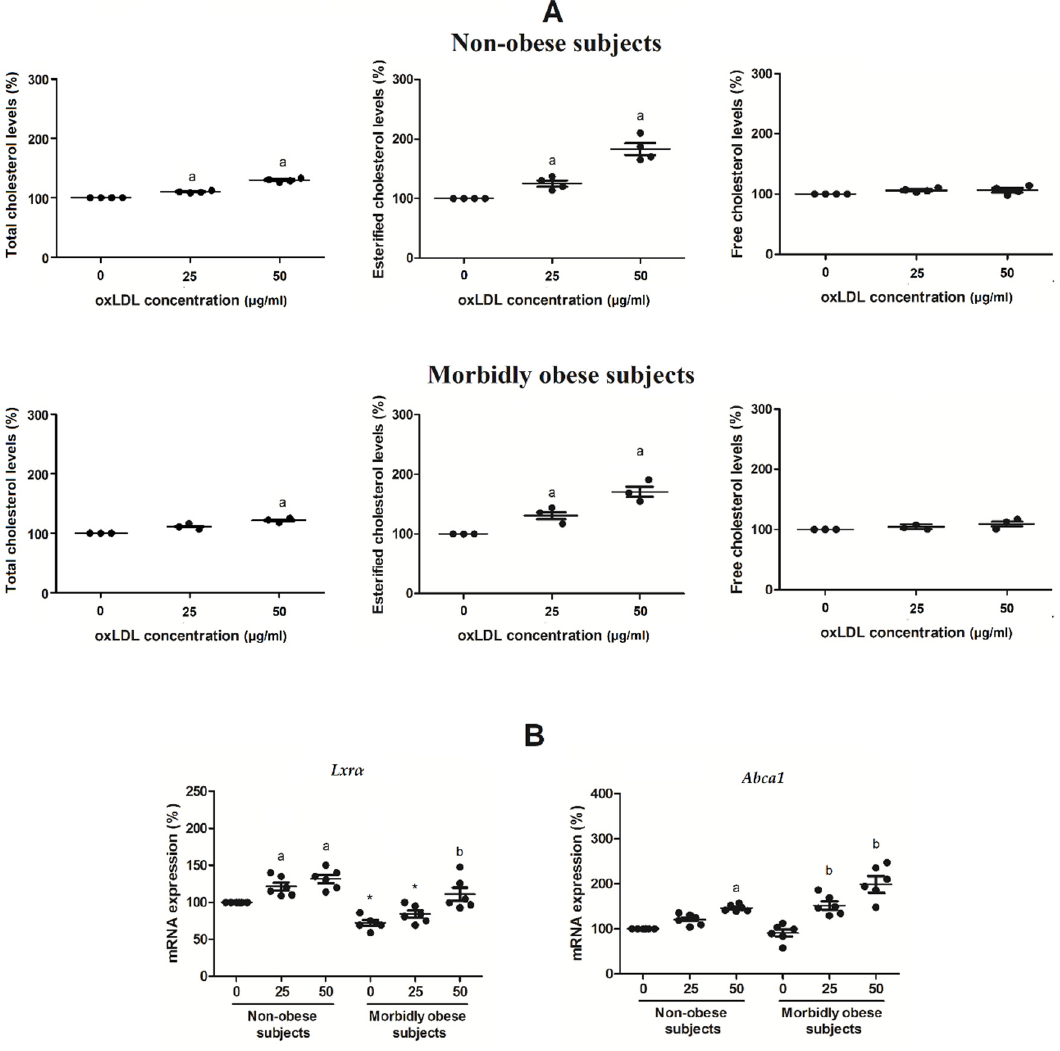
Figure 2. ( A ) Total cholesterol, esterified cholesterol and free cholesterol levels in human visceral in vitro differentiated adipocytes from non-obese ( n = 4) and morbidly obese subjects ( n = 3) incubated with different doses of oxLDL (0, 25, and 50 μ g/mL oxLDL). a p < 0.05: significant differences with regard to 0 μ g/mL oxLDL. ( B ) levels of mRNA expression of Lxr α and Abca1 in human visceral in vitro differentiated adipocytes obtained from HMSC from non-obese ( n = 6) and morbidly obese subjects ( n = 6) incubated with 0, 25, and 50 μ g/mL of oxLDL. a p < 0.05: significant differences with regard to 0 μ g/mL oxLDL within non-obese subjects. b p < 0.05: significant differences with regard to 0 μ g/mL oxLDL within morbidly obese subjects. * p < 0.05: significant differences for each dose between non-obese and morbidly obese subjects.